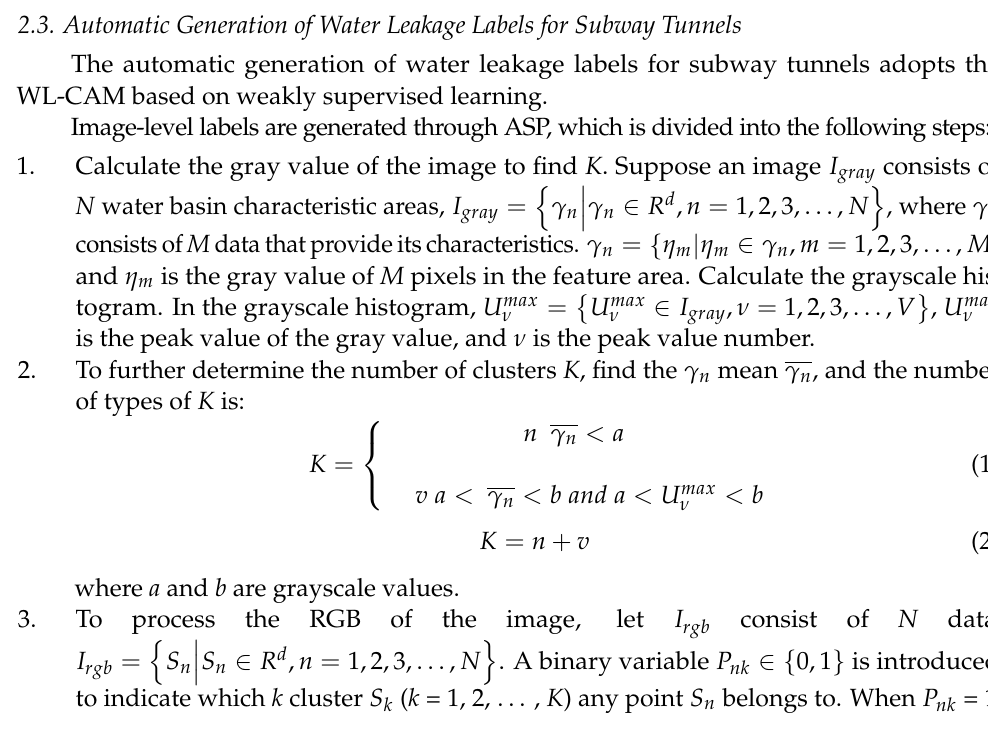
Figure 3. The overall framework of the HSL.